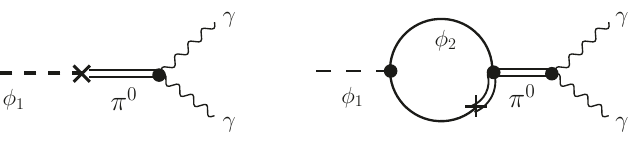
Figure 8 . CP violating contributions to (cid:30) 1